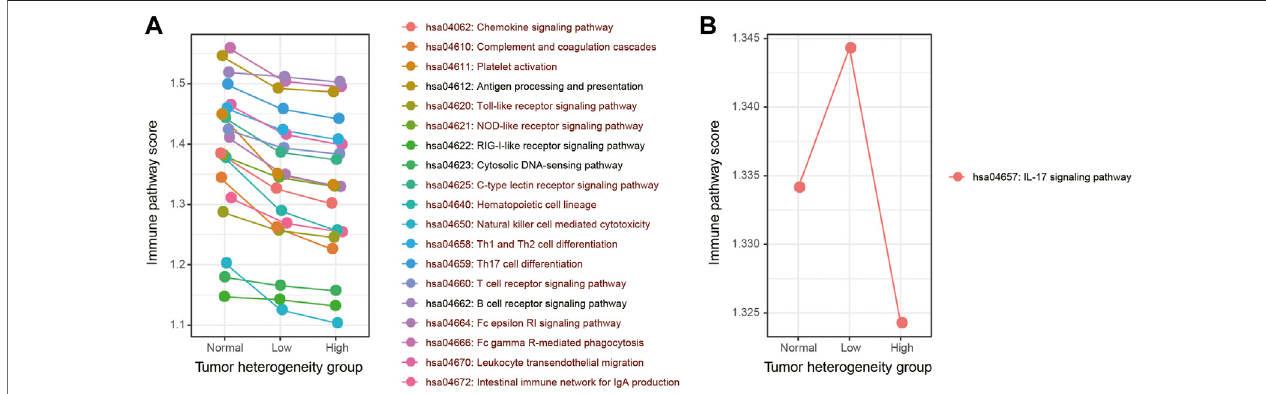
FIGURE 3 | Activity score of each immune pathway in three groups calculated by the ssGSEA algorithm. (A) Immune pathways which showed a continuous decreasing trend. (B) Immune pathways which showed an upward trend, followed by a downward trend. The immune pathways whose activity scores have signi fi cant differences among three groups are marked in dark red.